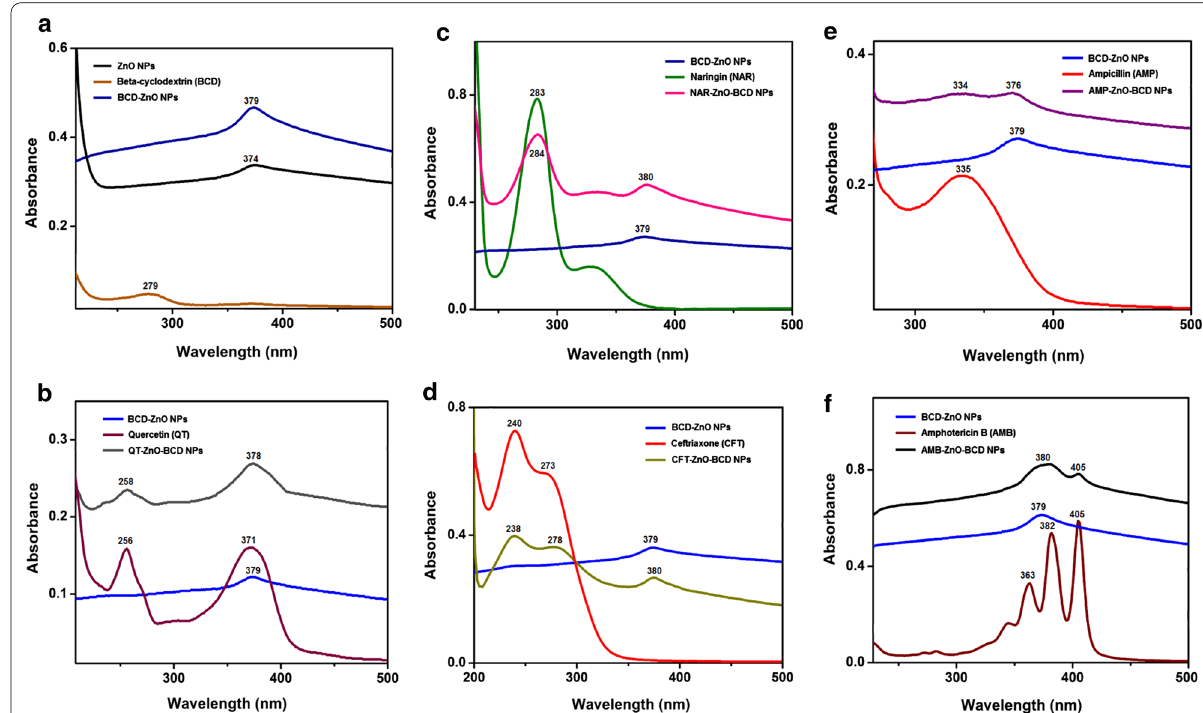
Fig. 1 Representing the UV-visible absorption spectra of nanoparticle, reducing/capping agent and different drugs conjugates. a Represents UV spectra of ZnO NPs, beta-cyclodextrin (BCD) and BCD-ZnO NPs, b showing spectra of BCD-ZnO NPs, quercetin and QT-BCD-ZnO NPs, c absorption spectra of BCD-ZnO NPs, naringin and NAR-BCD-ZnO NPs, d absorption spectra of BCD-ZnO NPs, ceftriaxone and CFT-BCD-ZnO NPs, e absorption spectra of BCD-ZnO NPs, ampicillin and AMP-BCD-ZnO NPs and f illustrating absorption spectra of BCD-ZnO NPs, amphotericin B and AMB-BCD-ZnO